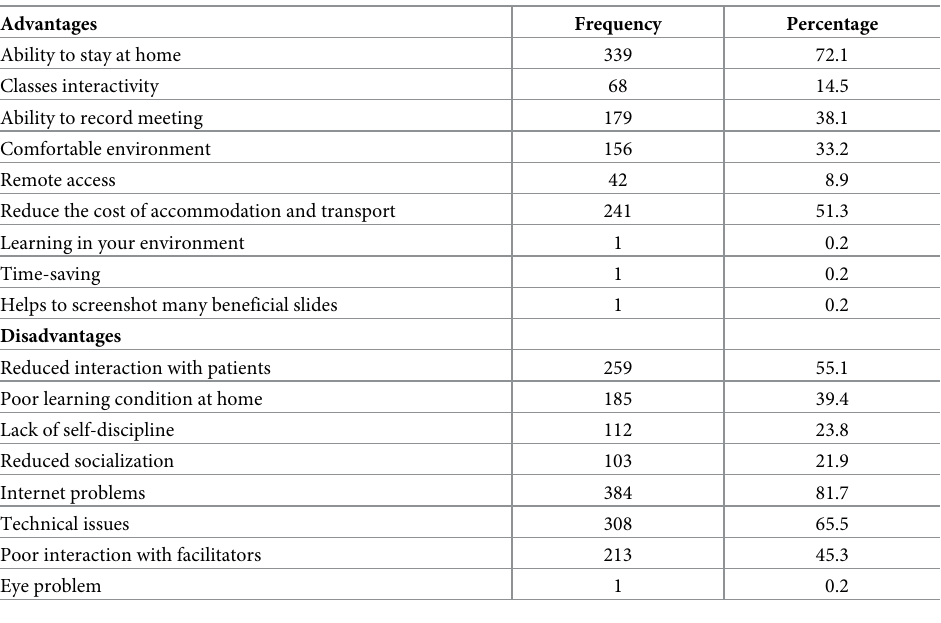
Table 2. Advantages and disadvantages of e-learning (n =